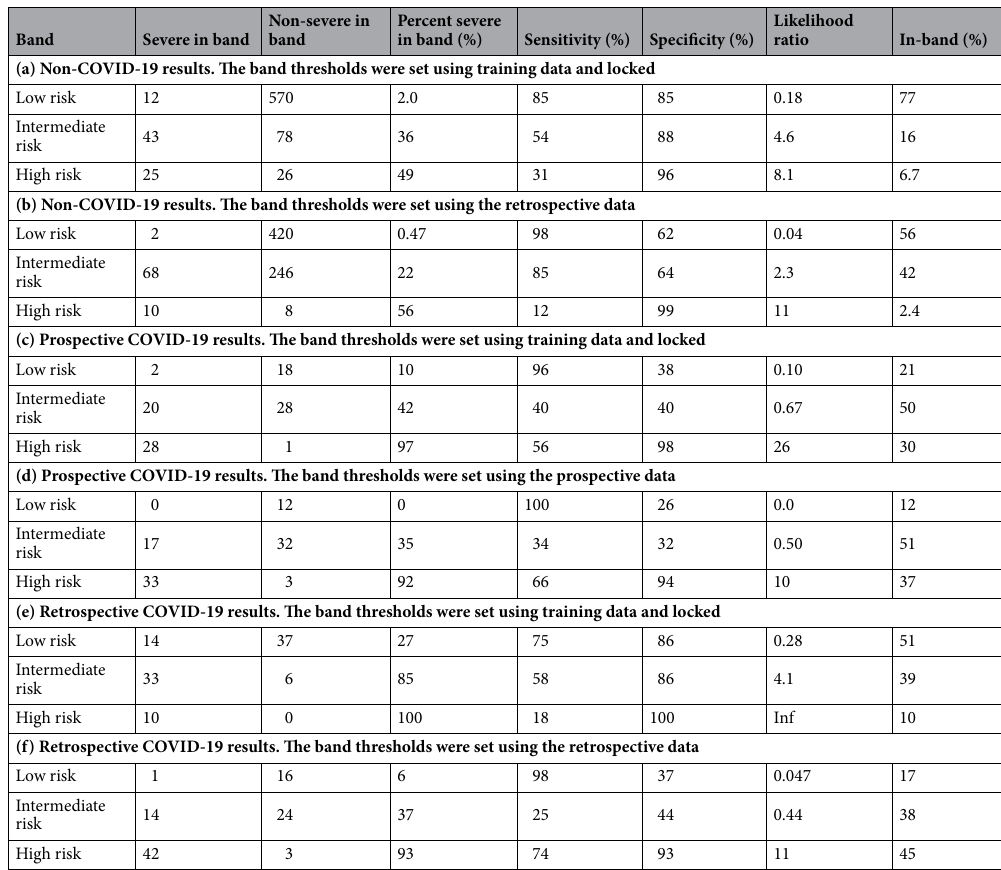
Table 4. Test characteristics of the 6-mRNA score in non-COVID-19 and COVID-19 patients using the three-band test report. “Severe in band” is the number of patients with severe viral infection assigned to the corresponding band. “Non-severe in band” is the number of patients with non-severe viral infection assigned to the corresponding band. The “Percent severe in band” is the percentage of patients in the band who had severe outcome. The “In-band” column is the percentage of patients assigned by the classifier to the corresponding